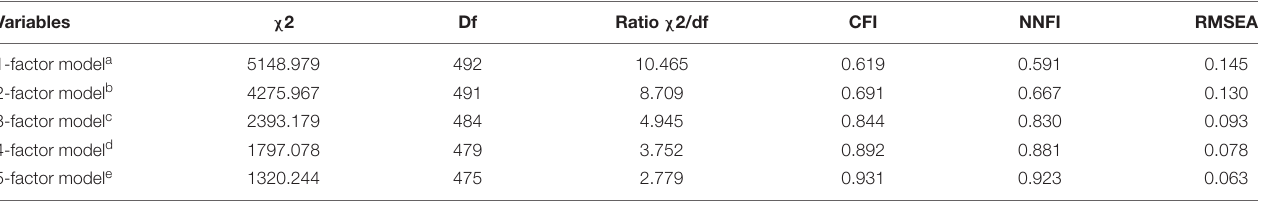
TABLE 2 | Outcomes of confirmatory factor analyses